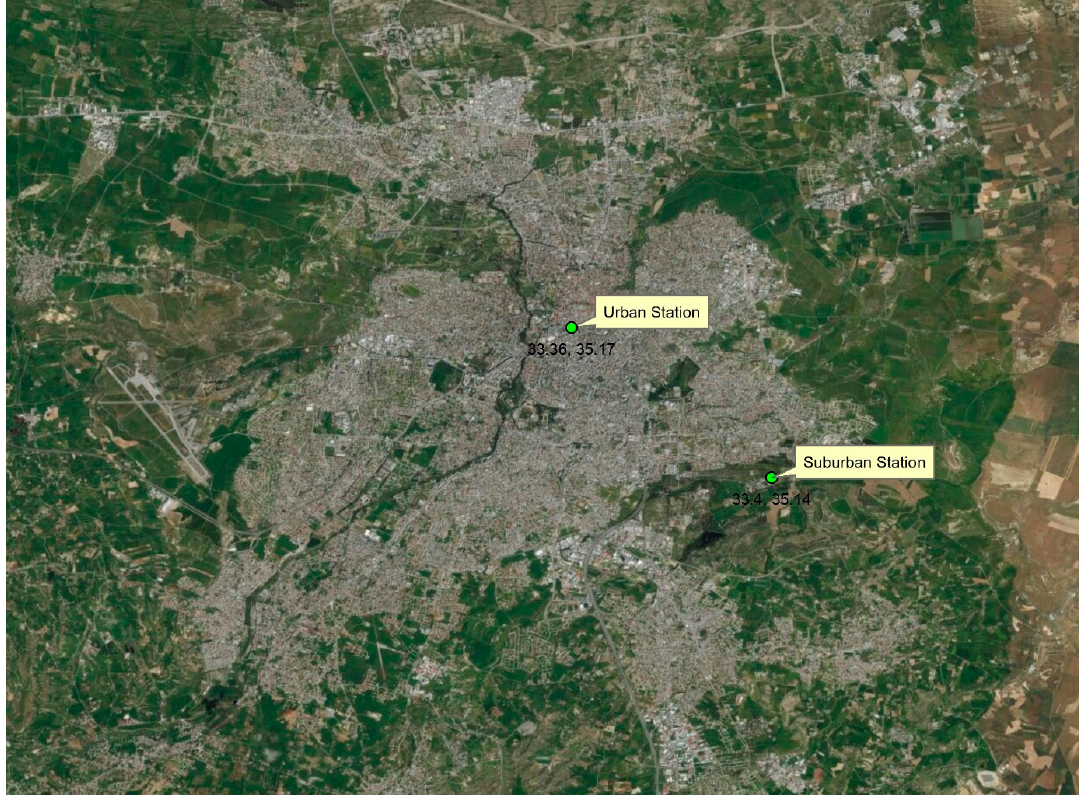
Figure 2. Map of Nicosia for year 2017 showing the location of the urban and suburban stations.